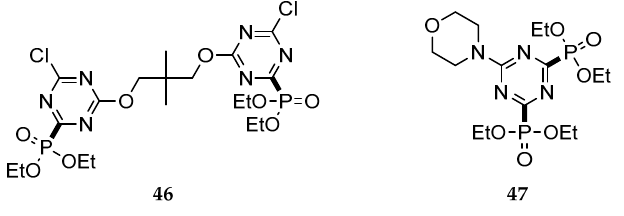
Figure 21. Triazine derivatives 46 and 47 .